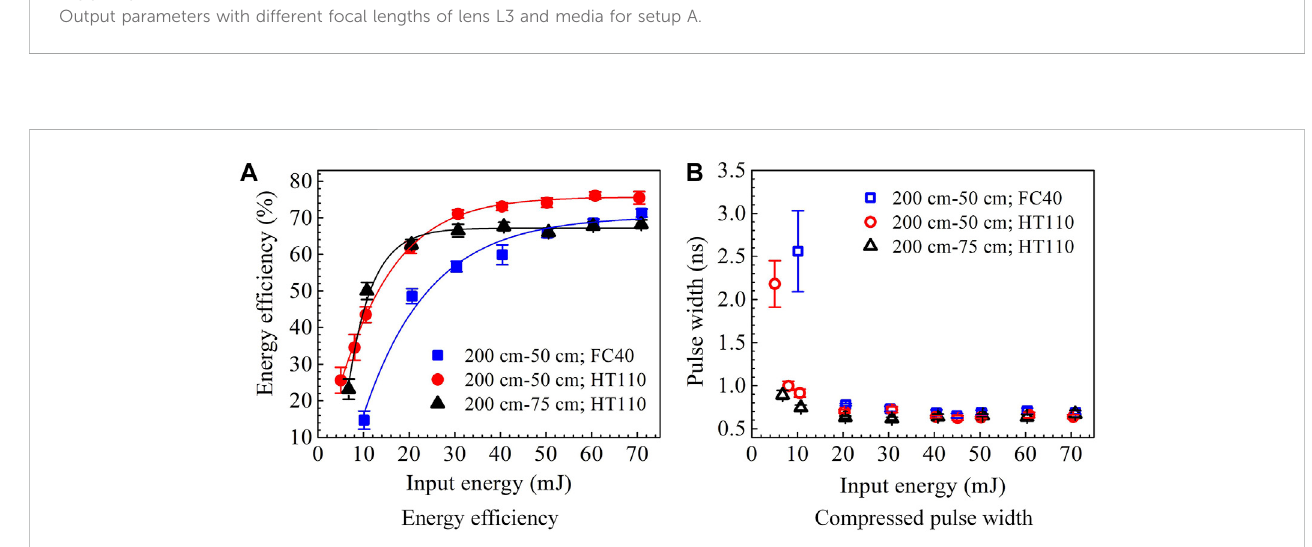
FIGURE 4 Output parameters with different focal lengths of lens and media for setup